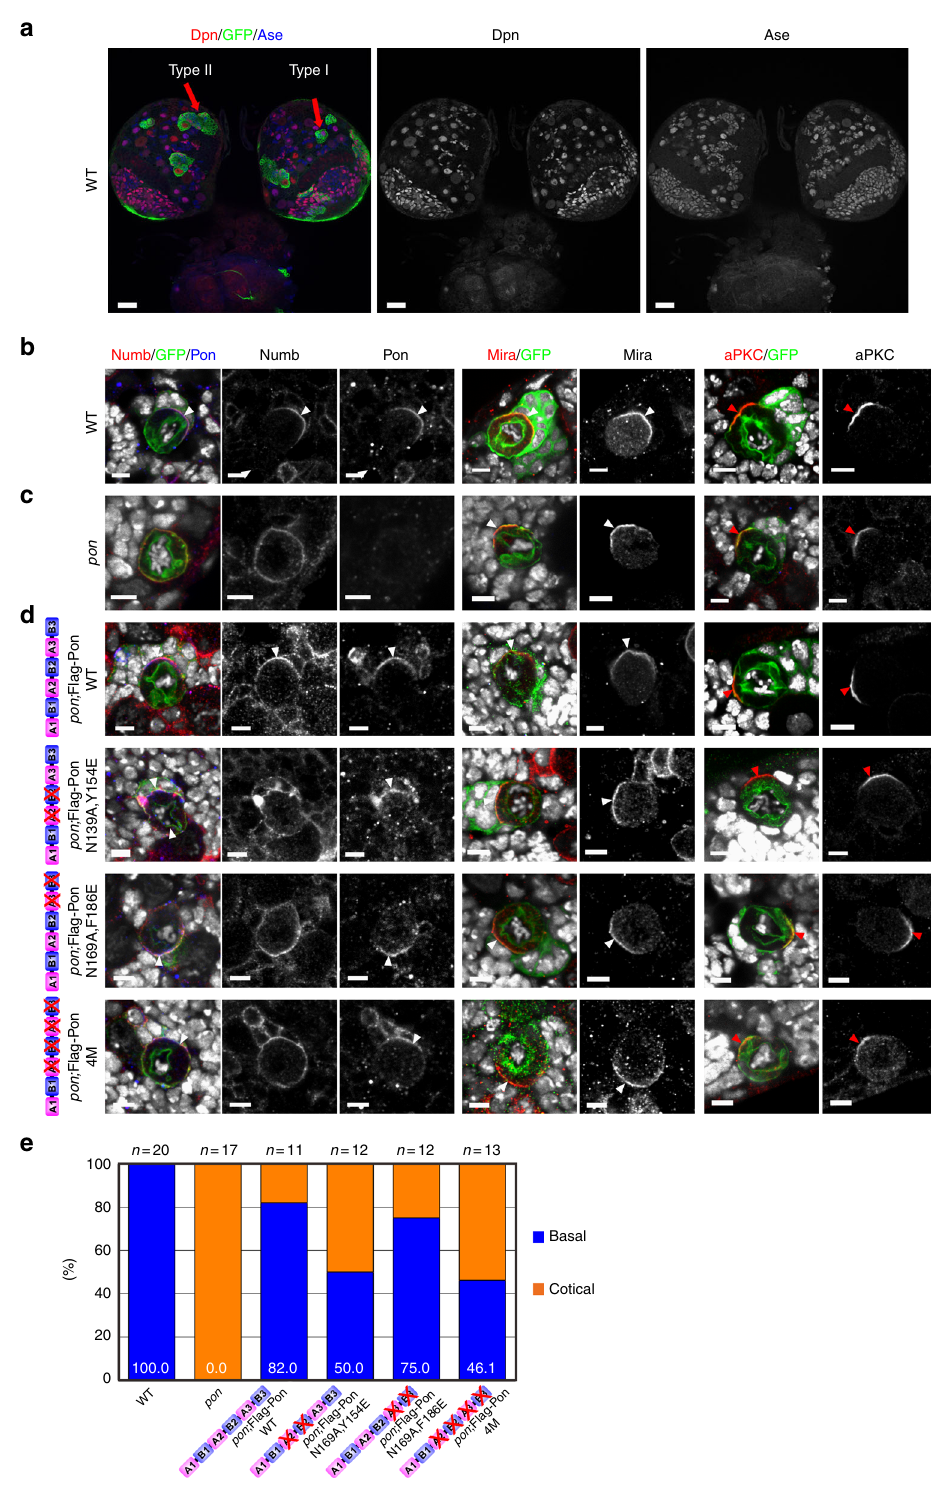
Fig. 7 Direct interaction between Pon AB motif repeats and Numb PTB is required for Numb localization during the asymmetric divisions of Drosophila larval NBs. a Overview of fl y brain showing type I and type II lineage. b – d NBs are marked by GFP using MARCM technique (see Methods). ToPro-3 is in white. Staining of various apical and basal proteins (red or blue) and GFP (green) in larval NBs derived from WT ( b ), pon mutant ( c ), and pon mutant expressing a Flag-Pon WT or mutant variants ( d ). b Numb and Pon are basally localized in wild-type NBs. c Pon is not detected in pon mutant NBs, whereas Numb is uniformly localized on cortex as well as some cytoplasm in pon mutant NBs. Mira and aPKC are normally localized in pon mutant NBs. d In pon mutant NBs rescued with Flag-Pon WT, majority (82%) of NBs exhibit basal localization of Pon and Numb. Interestingly, in pon mutant NBs rescued with Flag-Pon N139A,Y154E, Flag-Pon N169A,F186E, or Flag-Pon 4M, majority of these NBs showing broad cortical as well as some cytoplasmic localization of Numb, although all the Flag-Pon variants are basally localized. Mira and aPKC are normally localized in these NBs. White arrowheads label basal cortex, whereas red arrowheads indicate apical cortex. Scale bars, 25 µ m for the whole brain in a and 5 μ m for rest NB images. e Statistical data of Numb localization for b –